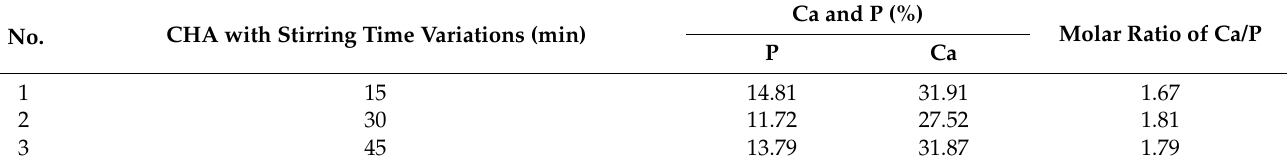
Table 2. Composition of CHA.